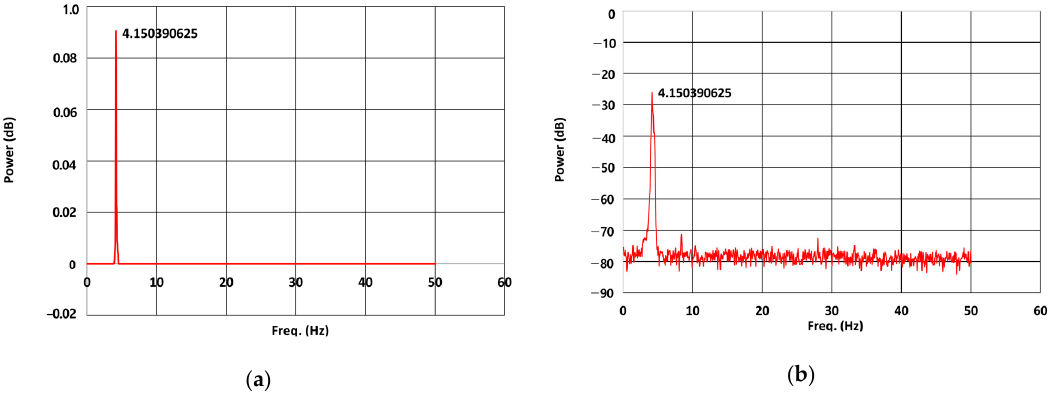
( b ) Figure 11. Dynamic test measurements: ( a ) Accelerometer data; ( b ) FBG data. In order to analyze the frequency contents of the vibration test data from the accel- erometers and FBG sensor, the Welch method [17] was adopted to estimate the averaged